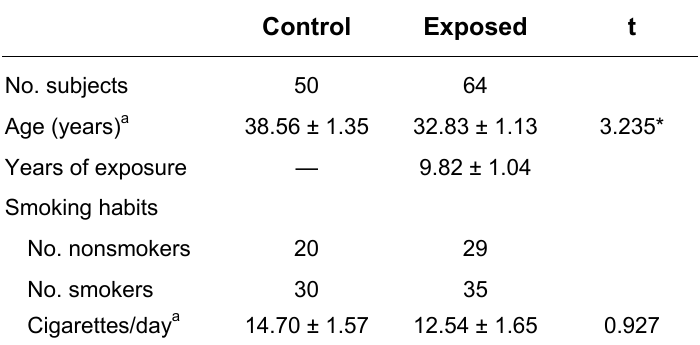
Characteristics of the Studied